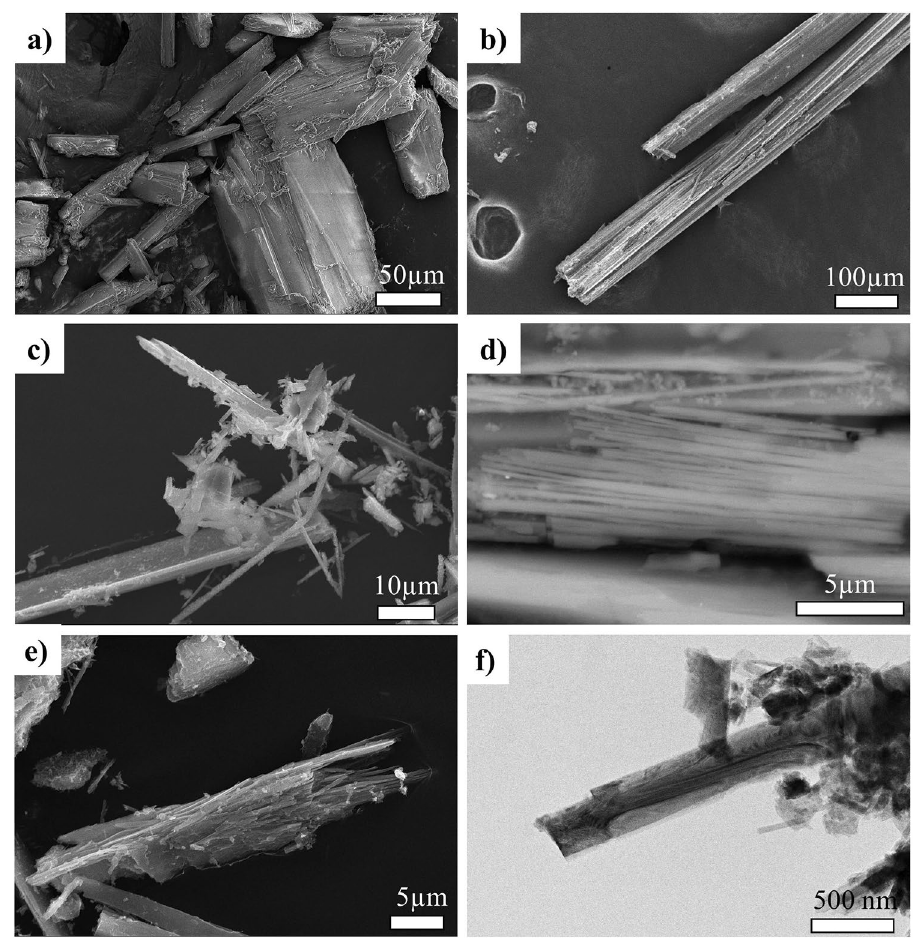
Figure 3. SEM and TEM images of tremolite find in the sample SMA1971-214. ( a ) SEM images of columnar aggregates with elongated prismatic habit. ( b ) SEM image of fibres bundles. ( c ) Tremolite asbestos fibres, ( d ) SEM images of tremolite fibres bundles. ( e ) SEM images of bundle of thin tremolite fibres, ( f ) TEM images of the tremolite single fibre and encrusting lizardite.